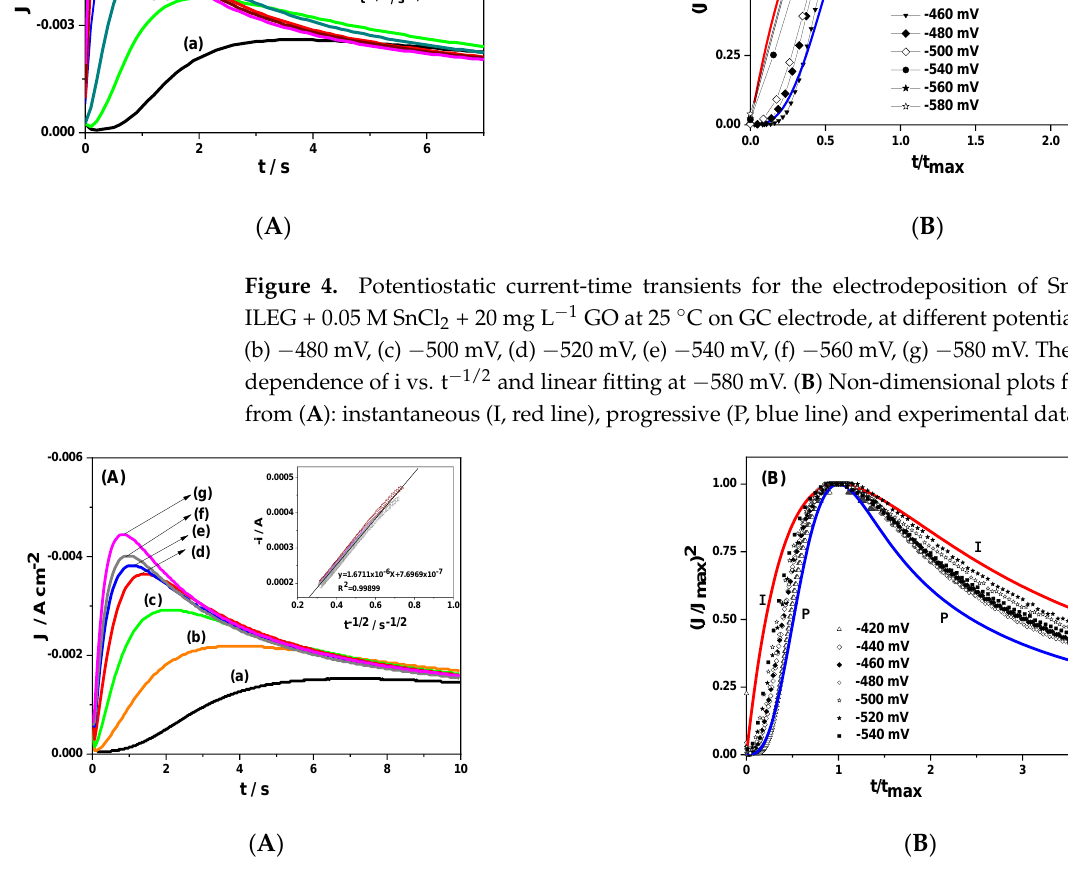
Figure 5. Potentiostatic current-time transients for the electrodeposition of Sn ( A ) from ILEG + 0.05 M SnCl 2 at 25 °C on GC electrode, at different potentials: (a) − 420, (b) − 440, (c) − 460, (d) − 480, (e) − 500, (f) − 520, (g) − 540 mV. The inset shows the dependence of i vs. t − 1/2 and linear fitting at − 520 mV. ( B ) Non-dimensional plots for the transients from ( A ): instantaneous (I, red line), progressive (P, blue line) and experimental data (black